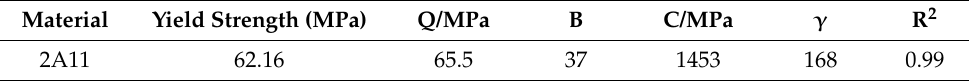
Table 3. Parameters obtained in the combined hardening